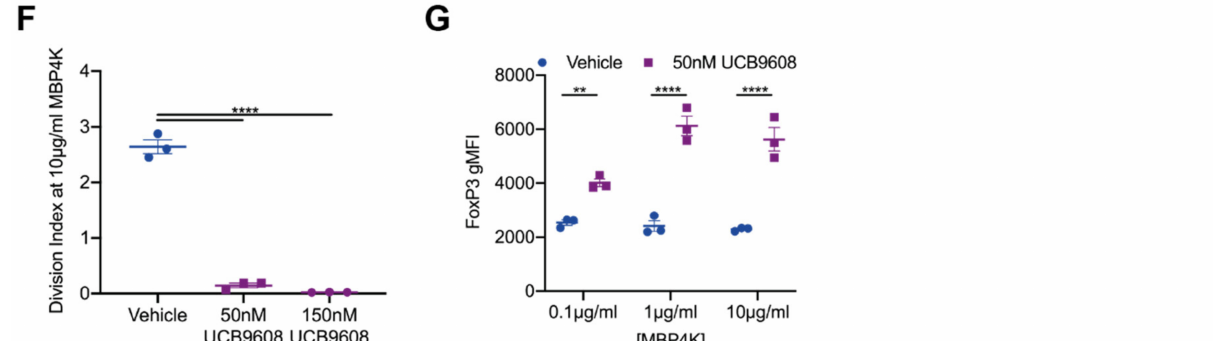
Figure 1. Three experimental models of T cells with regulatory capability. ( A ) Schematic of Tg4 T cell culture to generate Teff pep, iTreg pep, Ttol and Teff iPI4K cells; ( B ) Tg4 splenocytes were incubated with 10 µ g/mL MBP Ac1-9[4K] peptide for 5 days in the presence of 50 U/mL IL-2 or 10 ng/mL TGF β and 100 U/mL IL-2 and stained for CD4 and FoxP3. Data are expressed as % FoxP3 + cells (n = 4–12 independent experiments). **** p < 0.0001; ( C ) Tg4 splenocytes were incubated with 10 µ g/mL MBP Ac1-9[4K] peptide for 6 days in the presence of 50 U/mL IL-2 or 10 ng/mL TGF β plus 100 U/mL IL-2 and IFN γ and IL-10 amounts in tissue culture supernatants were determined by ELISA. Data are expressed as amount of cytokine (n = 5 independent experiments). * p < 0.05, ** p < 0.01; ( D ) Tg4 eff pep or iTreg pep cells were re-activated with PL8 APCs (10 µ g/mL Ac1-9[4Y]) for 18 h and IL-10 amounts were determined by ELISA. Data are expressed as amount of cytokine (n = 6 independent experiments); ( E ) Tg4 T cells were tolerized in vivo with a dose escalation of MBP Ac1-9[4K] peptide in PBS or left untreated, incubated in vitro with 10 µ g/mL MBP Ac1-9[4K] peptide for 5 days in the presence of 50 U/mL IL-2, retrovirally transduced to express GFP, re-activated with PMA and Ionomycin and stained for LAG-3, PD-1, intracellular IL-10 and IFN γ . Data are expressed as % T cells positive for the indicated marker (n = 3). * p < 0.05, ** p < 0.01, *** p < 0.001; ( F ) Naïve Tg4 T cells were labelled with the cell proliferation dye CellTrace Violet and incubated with irradiated splenocytes and the indicated concentrations of MBP Ac1-9[4K] peptide for 4 days in the presence of 50 U/mL IL-2 with the indicated concentration of UCB9608 or vehicle. Data are expressed as the average number of cell divisions (‘division index’) at an MBP Ac1-9[4K] peptide concentration of 10 µ g/mL. **** p < 0.0001; ( G ) Tg4 splenocytes were incubated with the indicated concentrations of MBP Ac1-9[4K] peptide for 6 days in the presence of 50 U/mL IL-2 with 50 nM UCB9608 or vehicle and stained for FoxP3. Data are expressed as MFI of FoxP3 + (n = 3). ** p < 0.01, **** p <